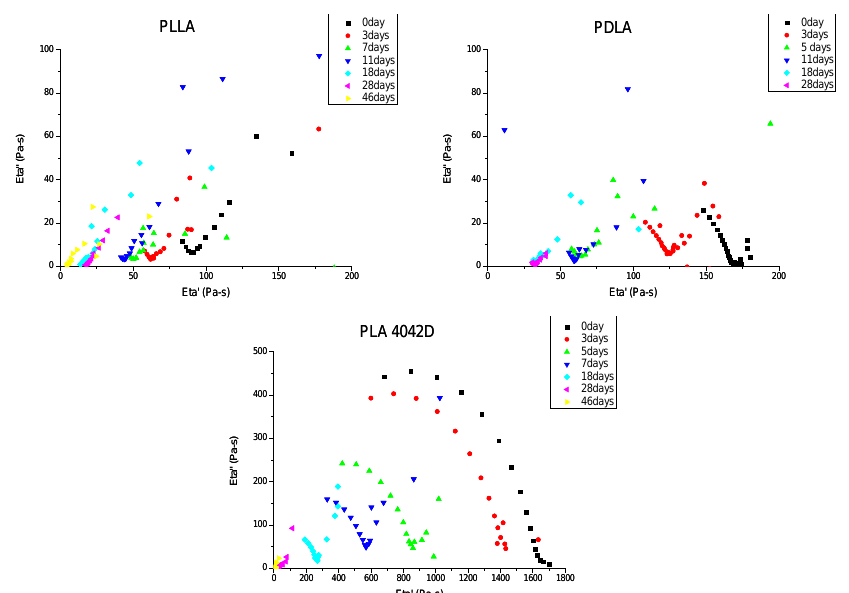
Figure 2. Cole–Cole plots of PLLA, PDLA and PLA4042D during composting (0 to 46 days). Viscoelastic experiments were performed at T = 180 °C.